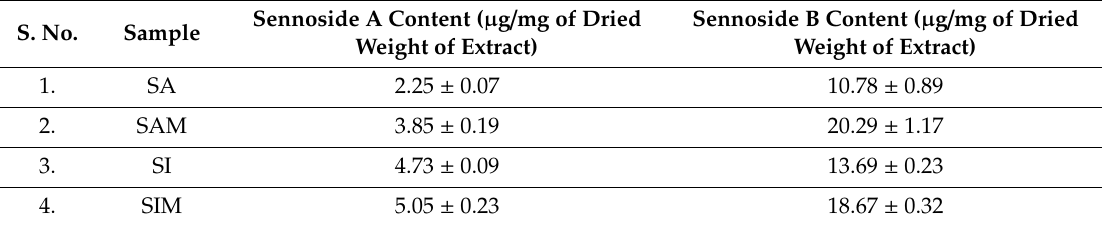
Table 1. HPLC–UV analysis of sennoside A and sennoside B in SA, SAM, SI, and SIM. S. No.